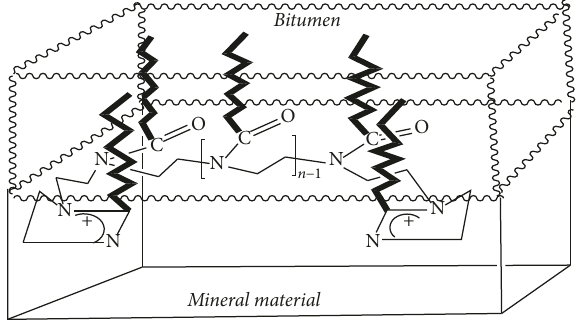
Figure 2: Location of bisimidazoline molecules on the interface “bitumen-mineral